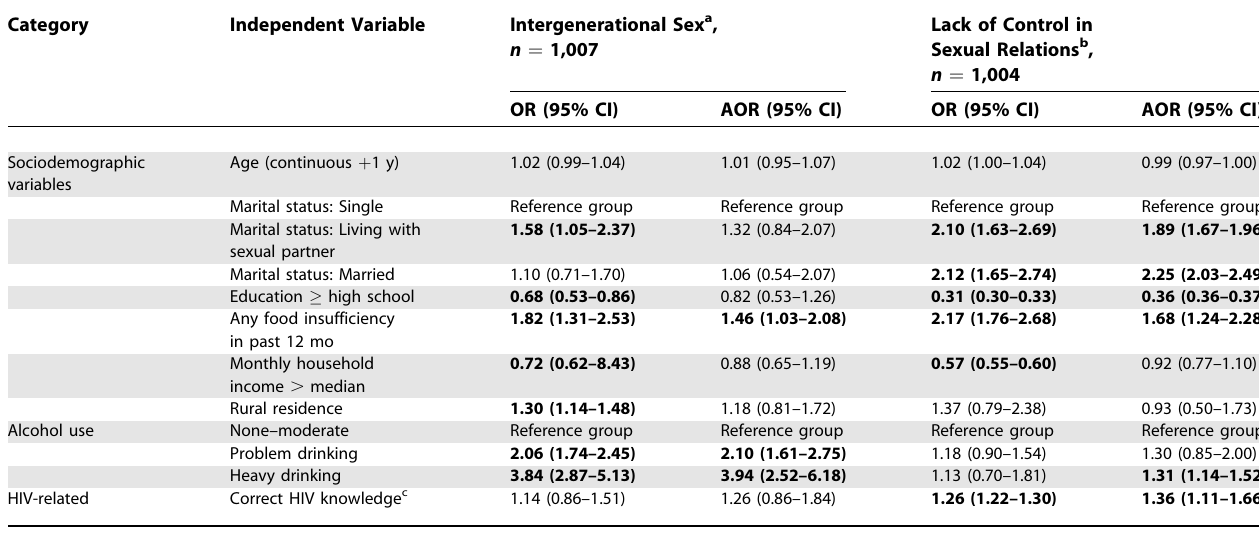
Table 3. Unadjusted and Adjusted Associations with Intergenerational Sex and Lack of Control in Sexual Relations for Women, Botswana and Swaziland 2004–2005